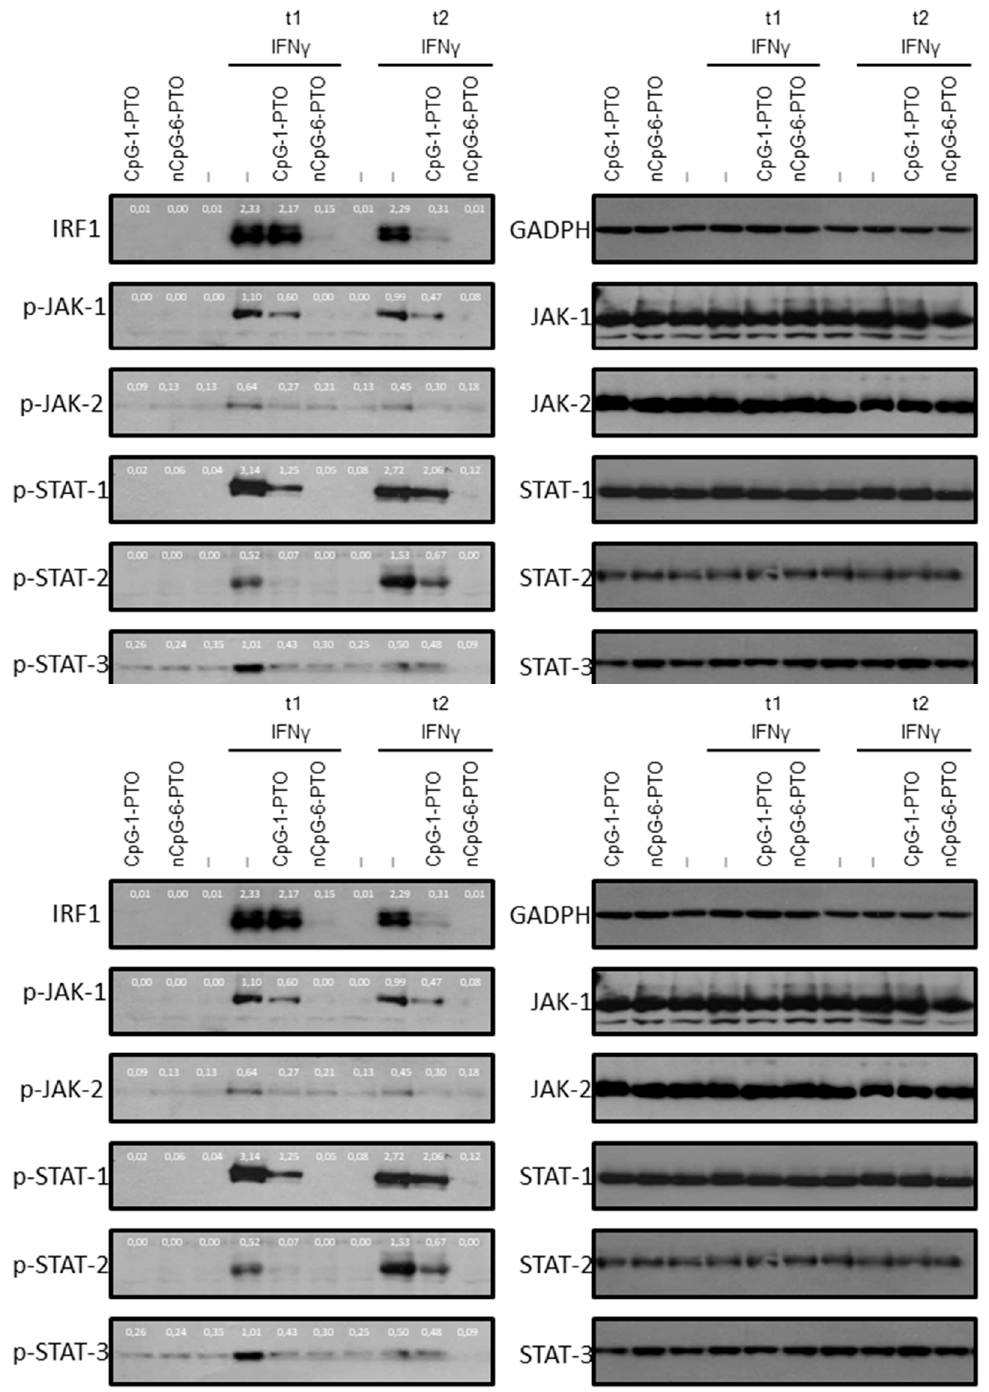
Figure 5. Western blot analysis of interferon receptor signaling proteins. A375 cells were treated with 4 µ M CpG-1-PTO or 4 µ M nCpG-6-PTO without further stimulation (basal activation, row 1–3) or with additional stimulation with IFN γ for two time periods (t1 and t2). Protein extracts were subjected to Western blot analysis and tested for expression of IRF1 (t1: 60 min, t2: 3 h), p-JAK-1 (t1: 10 min; t2: 30 min), p-JAK-2 (t1: 10 min; t2: 30 min), p-STAT-1 (t1: 10 min; t2: 30 min), p-STAT-2 (t1: 10 min; t2: 30 min) and p-STAT-3 (t1: 10 min; t2: 30 min). Equal loading was monitored using antibodies directed against the total form of the phospho-protein, or in the case of IRF1 by GAPDH (blots on the right). The blots show representative results (n = 3). p-: phospho.